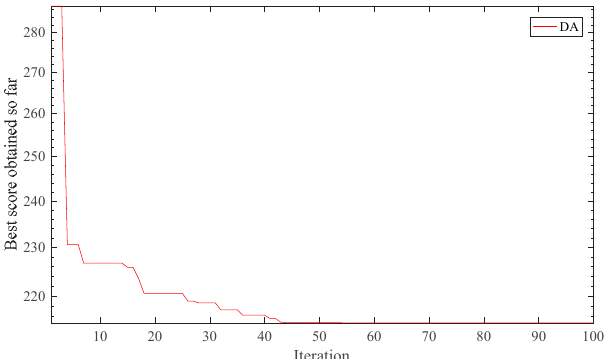
Figure 14. Iterative result diagram of dragonfly algorithms in grid-connected operation mode.